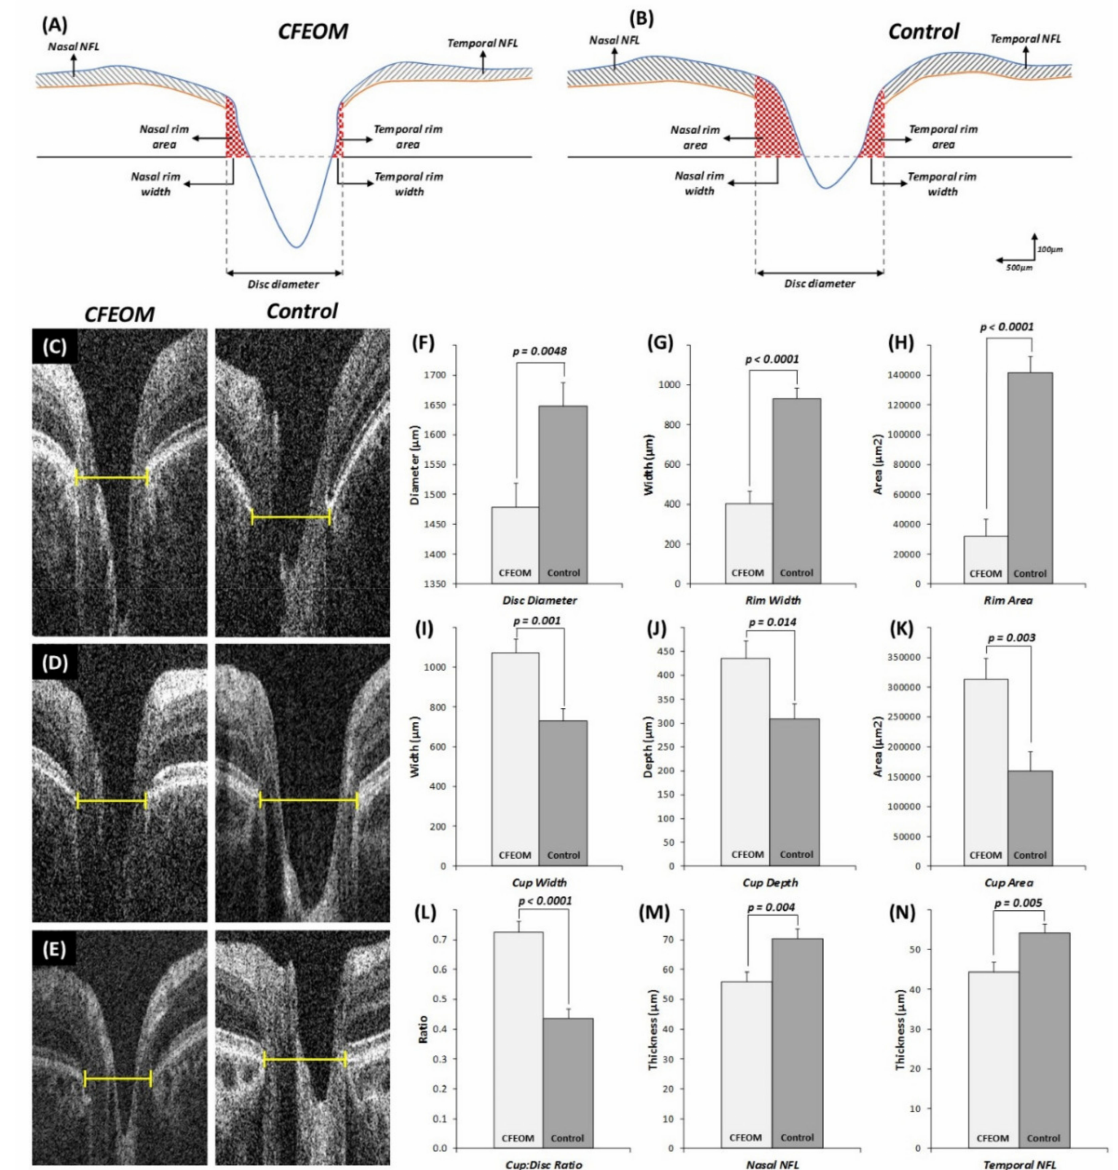
Figure 4. Schematic representation based on average measurements of disc parameters in CFEOM ( A ) and controls ( B ). Examples of disc optical coherence tomograms in CFEOM patients and controls ( C – E ). Yellow lines represent the horizontal disc diameters measured from the termination of the retinal pigment epithelium. Graphs show mean and error bars representing the standard error of mean for disc diameter ( F ), rim width ( G ), rim area ( H ), cup width ( I ), cup depth ( J ), cup area ( K ), cup/disc ratio ( L ), nasal nerve fiber layer (NFL), thickness ( M ), and temporal NFL thickness ( N ). p values are shown above error